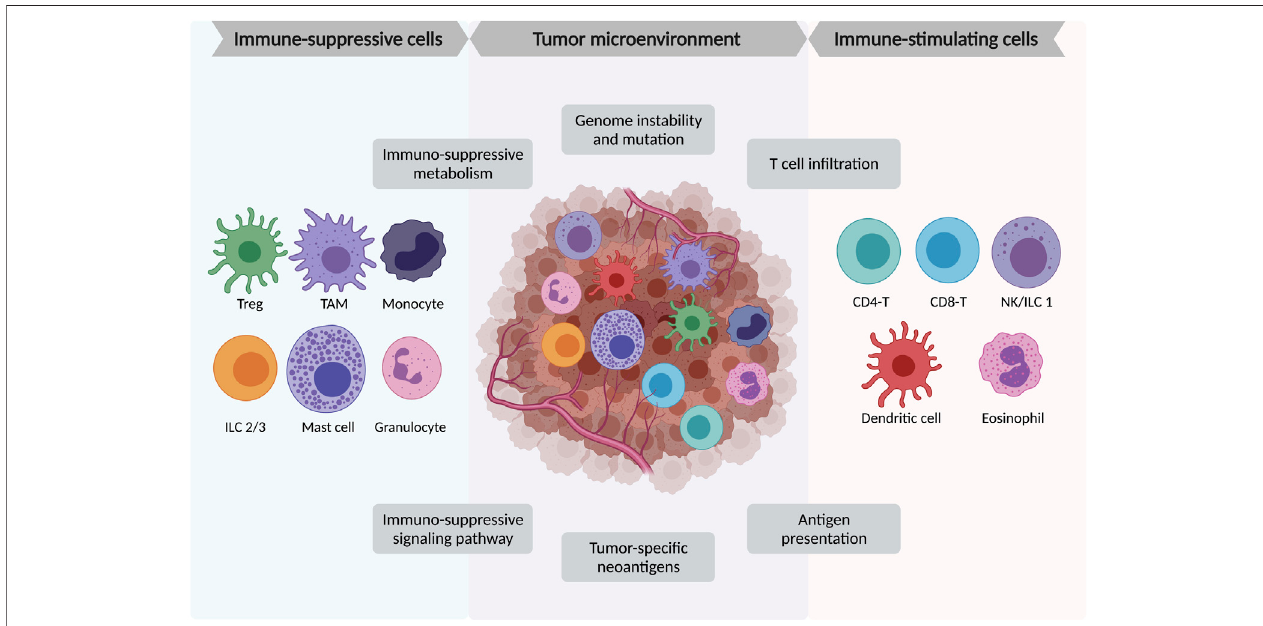
FIGURE 1 | Major immune cell components in tumor micro-environment (TME). TME is a complex structure containing heterogeneous tumor cells, blood vessels, variousimmunecells,stromalcells, andtheextracellularmatrix.Among theimmunecells, theimmune-suppressive cellsincludeFoxP3+regulatoryTcells(Treg),tumor- associated macrophages (TAMs), monocytes, innate lymphoid cells type 2 and 3 (ILC2/3), mast cells, and granulocytes. The immune-stimulating cells include tumor- in fi ltrating CD4+ and CD8+ lymphocytes, natural killer (NK) cells/innate lymphoid cells type 1 (ILC1), dendritic cells, and eosinophils.